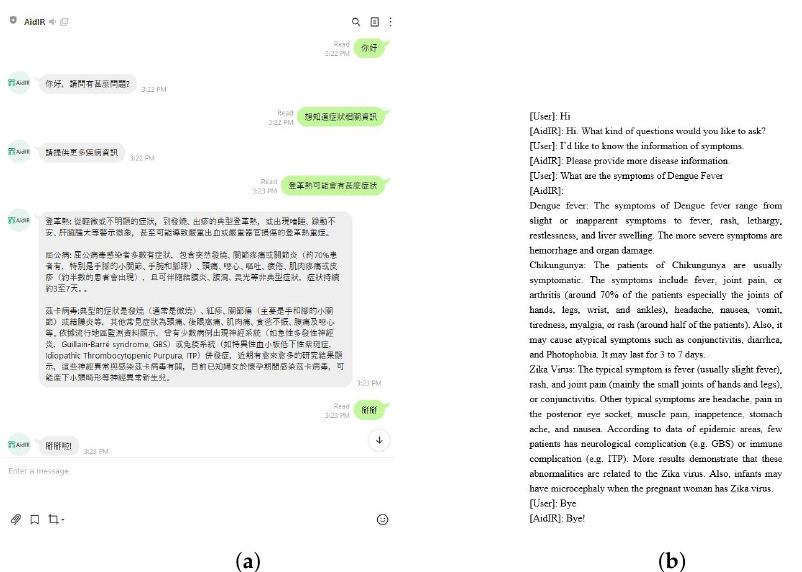
Figure 16. AidIR requests more information: ( a ) original dialog; and ( b ) dialog in